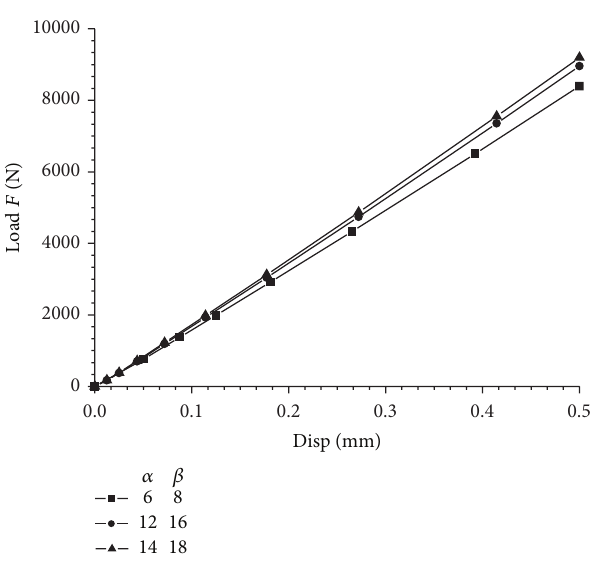
Figure 16: Stiffness curve in Z direction under different pattern slope angles.